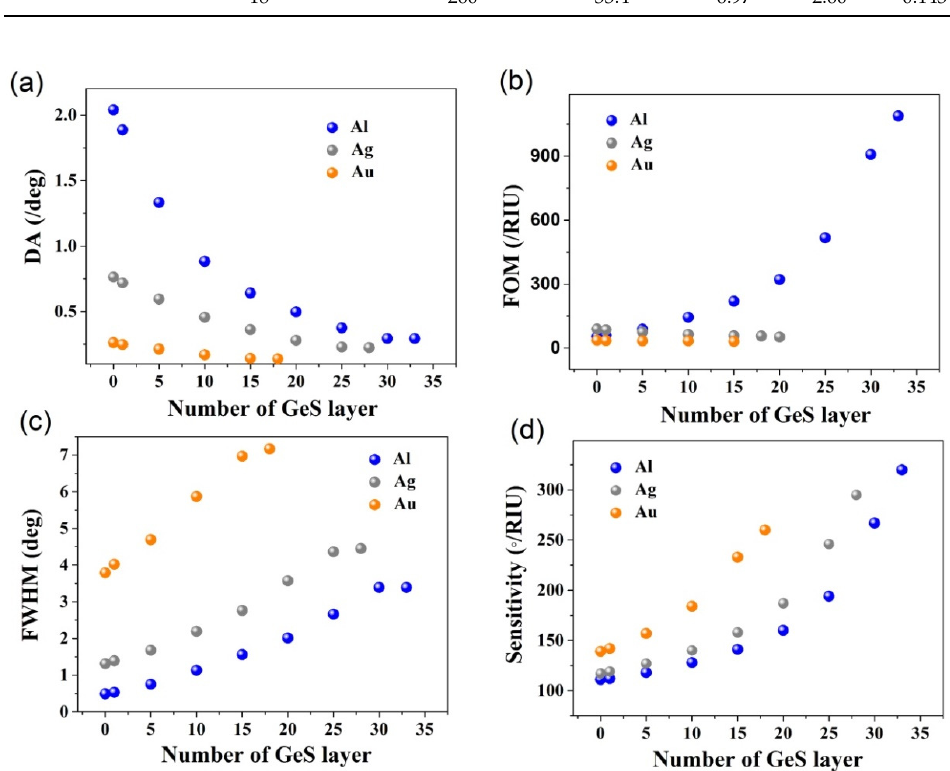
Figure 4. Variation in ( a ) DA , ( b ) FOM , ( c ) FWHM , and ( d ) sensitivities changing with numbers of GeS layers for the proposed SPR biosensors. The electric field distributions corresponding to the resonance angles are shown in Figure 5a,c,e. When the detection target refractive index is from 1.33 to 1.36, the electric field at the GeS/sending medium interface obviously varies dramatically. This indicates that the GeS based sensors are sensitive to small changes when checking detection target. When the refractive index of the detection medium on the contact surface changes a little bit, the surface wave property will have a large change, and then it will lead to a change in the electric field. Figure 5b,d,f shows that the changes in reflectance with the incident angles increase with increasing detection target refractive index, and the incident angles corresponding to the resonance angles increase. From n s = 1.33 to n s = 1.36, the resonance angles are 75.205°, 77.145°, 79.395°, and 82.150°, respectively.